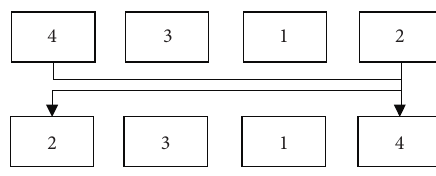
Figure 6: Swap illustration.